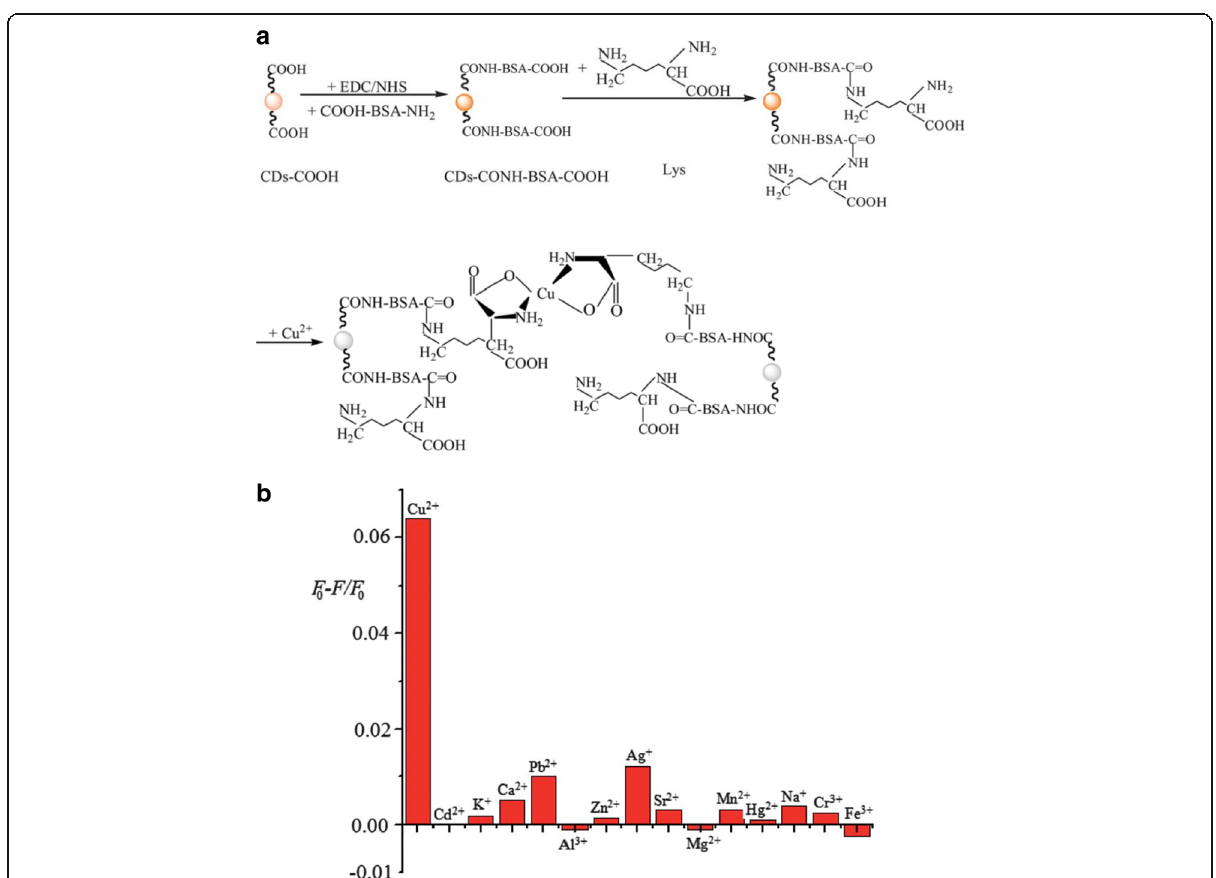
Fig. 9 a Schematic of the CD modification with BSA and Lys and Cu 2+ detection. b The selectivity of the CDs-BSA-lysine fluorescent probe toward 2 nmol Cu 2+ in the presence of other cations under optimum conditions